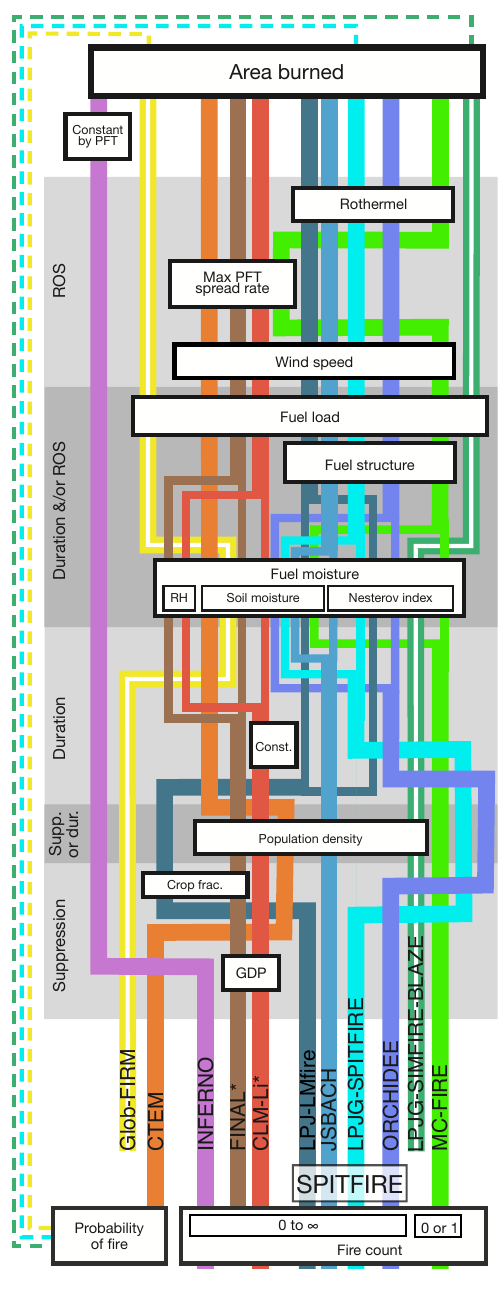
Figure 4. Modeled processes leading from fire starts (bottom; Fig. 3) to the calculation of burned area (top). The main processes include suppression, duration, and rate of spread (ROS). (Some variables can contribute to more than one of these processes; dark gray overlap areas.) “Suppression” refers to the reduction of burned area per fire. Some models apply this after the calculation of other terms (as in CLM- Li*, LM3-FINAL, LPJ-LMfire, and LPJ-GUESS-SIMFIRE-BLAZE) or it can affect fire duration (as in CTEM and JSBACH-SPITFIRE). Suppression can be a function of “GDP,” crop fraction (“crop frac.”), or “population density.” “Fuel structure” refers to the distribution of fuel among different size classes. The “Rothermel” equations (Rothermel, 1972) are used by some models to determine rate of spread based on fire intensity and other factors. The LPJ-GUESS models convert burned area to a probability of fire (dotted lines), burning individual patches stochastically. LPJ-GUESS-GlobFIRM and LPJ-GUESS-SIMFIRE-BLAZE are denoted with white stripes to indicate that they are using purely empirical formulas to calculate grid-cell-level burned area instead of simulating fire